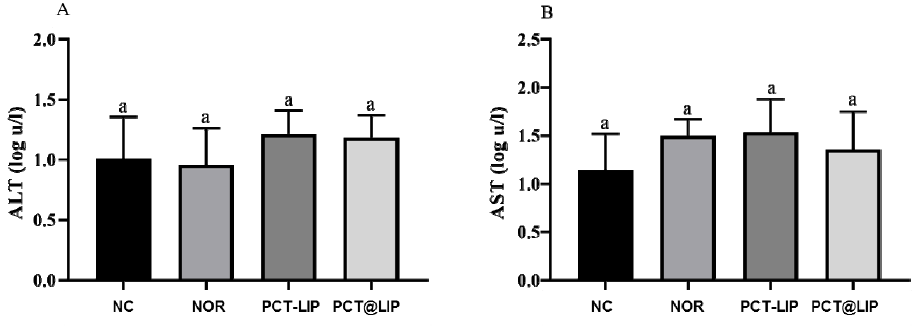
Figure 5. ALT ( A ) and AST ( B ) levels in AF of chicken embryos after treatment with free norfloxacin (NOR) or encapsulated in the formulations: PCT-LIP = conventional liposomes plus NOR at 20 μ g/mL blended with pectin solution, PCT@LIP = pectin-liposomal formulation containing NOR at 20 μ g/mL. NC = negative control, n = 10. Data expressed as mean ± SEM. Statistical test: One-way ANOVA/Tukey ( p < 0.05).